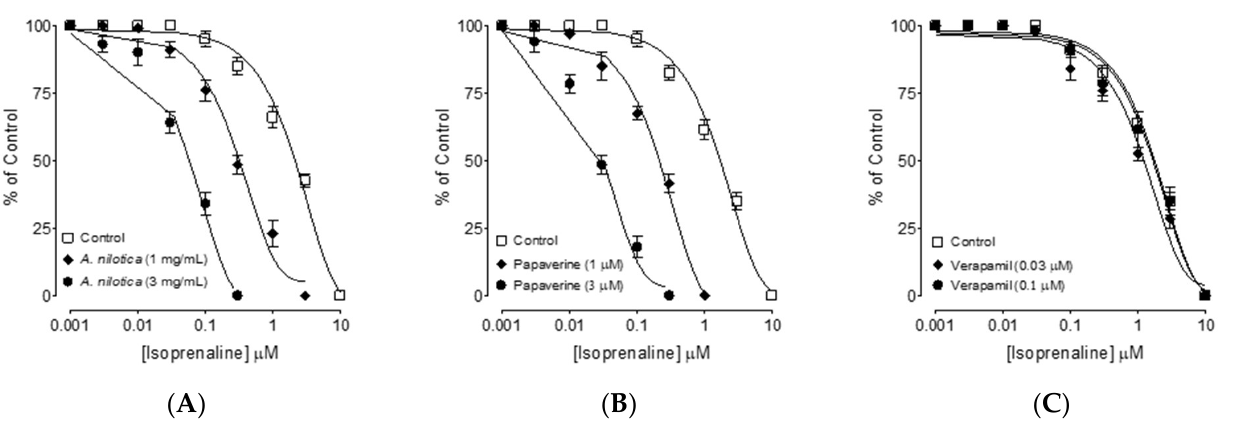
Figure 2. Concentration–response curves showing comparison of the ( A ) methanolic extract of A. nilotica , ( B ) papaverine, and ( C ) verapamil, for the inhibitory effect against carbachol (CCh; 1 µM) and high K + (80 mM)-induced contractions in isolated rat ileum preparations. Values shown are the mean ± SEM, n = 4–5. Pretreatment with A. nilotica (1 and 3 mg/mL) confirmed PDE inhibitory activity by shifting the isoprenaline-induced inhibitory CRCs to the left (Figure 3A), indicating a potentiating impact. Papaverine (1 and 3 µM) generated a comparable leftward shift in the isoprenaline curves, as seen in Figures 3B, while verapamil had no potentiating impact (Figure 3C).